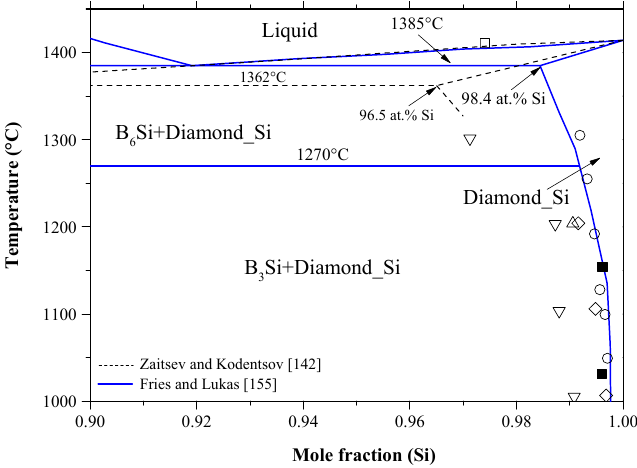
Figure 11. Magnified part of the B-Si system near the Si-rich side [155]; ----: [142]; Δ : [118]; ■ : [157]; □ : [144]; : [145]; : [146]; ○ : [148].